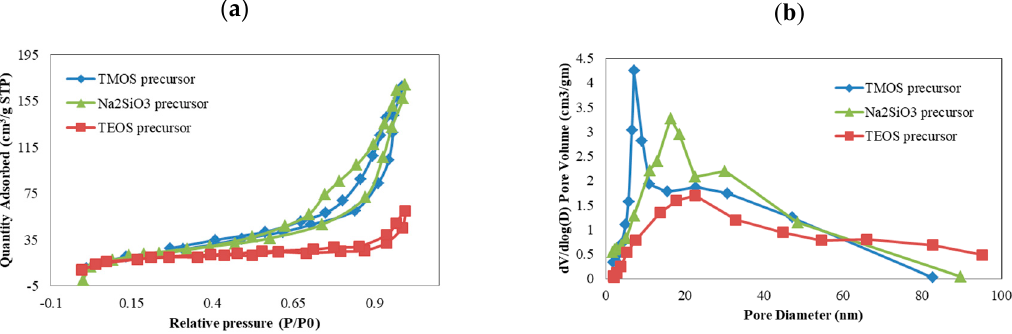
Figure 3. Adsorption–desorption isotherms ( a ) and pore-size distribution ( b ) for TMOS-, TEOS-, and Na 2 SiO 3 -based silica aerogels.